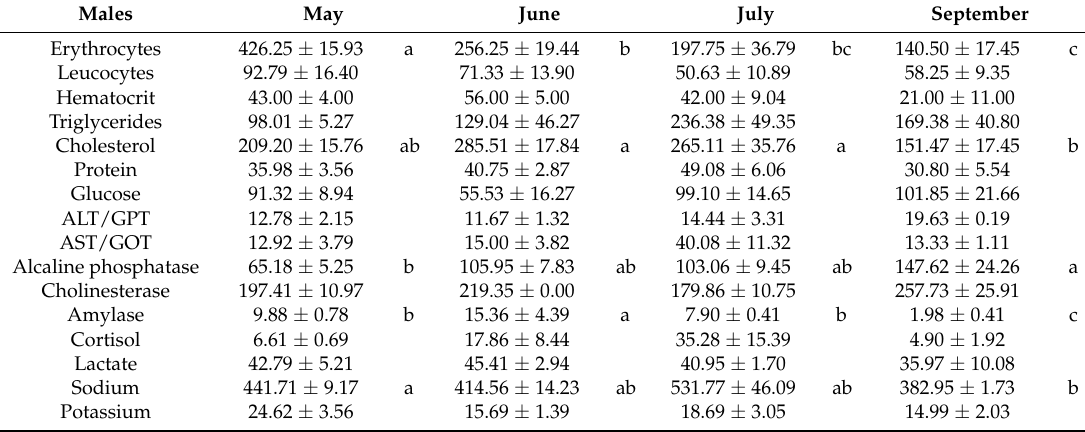
Table 5. Erythrocytes (10 4 mm − 3 ), leucocytes (10 3 mm − 3 ), hematocrit (%), triglycerides (mg dL − 1